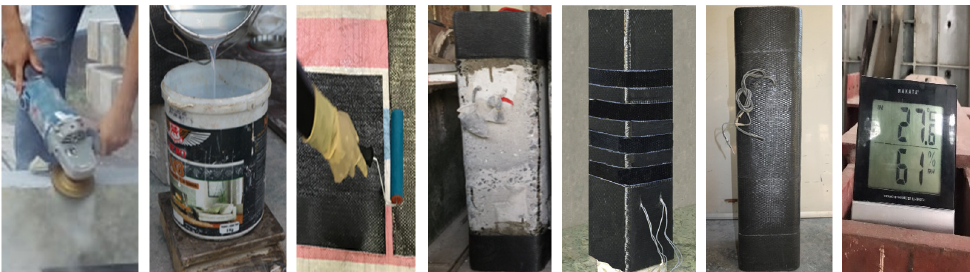
Figure 4. Procedure of strengthening with CFRP and curing.